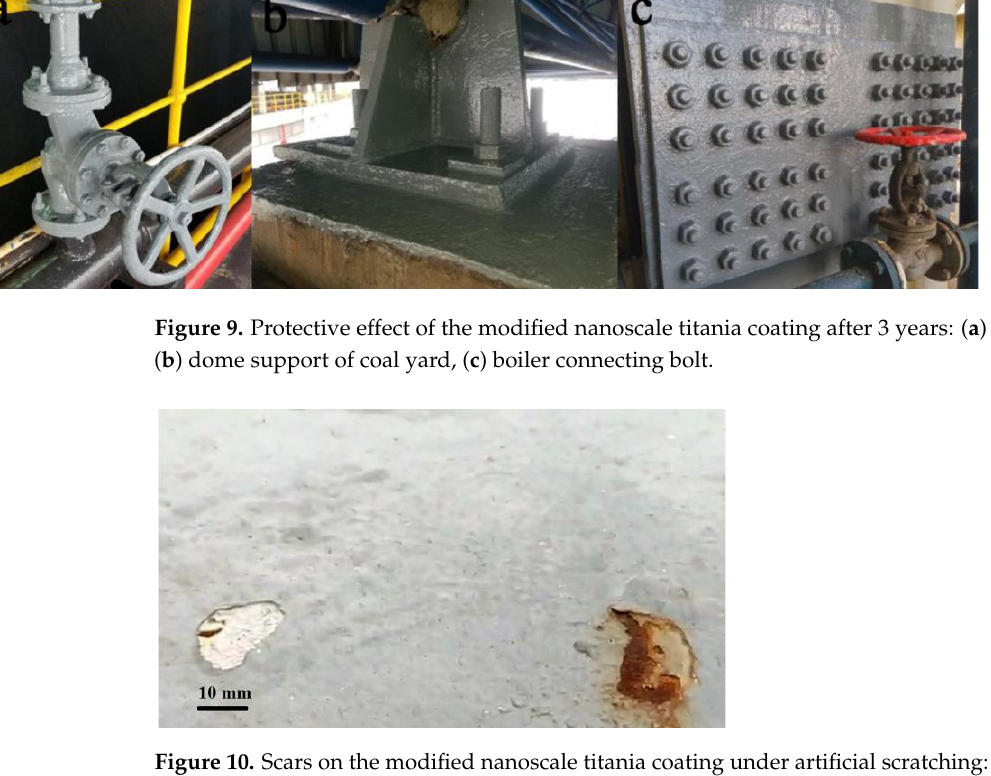
Figure 8. Protective effect of the usual polyurethane oily anticorrosive coating after 6 months: ( a ) pipeline valve, ( b ) dome support of coal yard, ( c ) boiler connecting bolt.